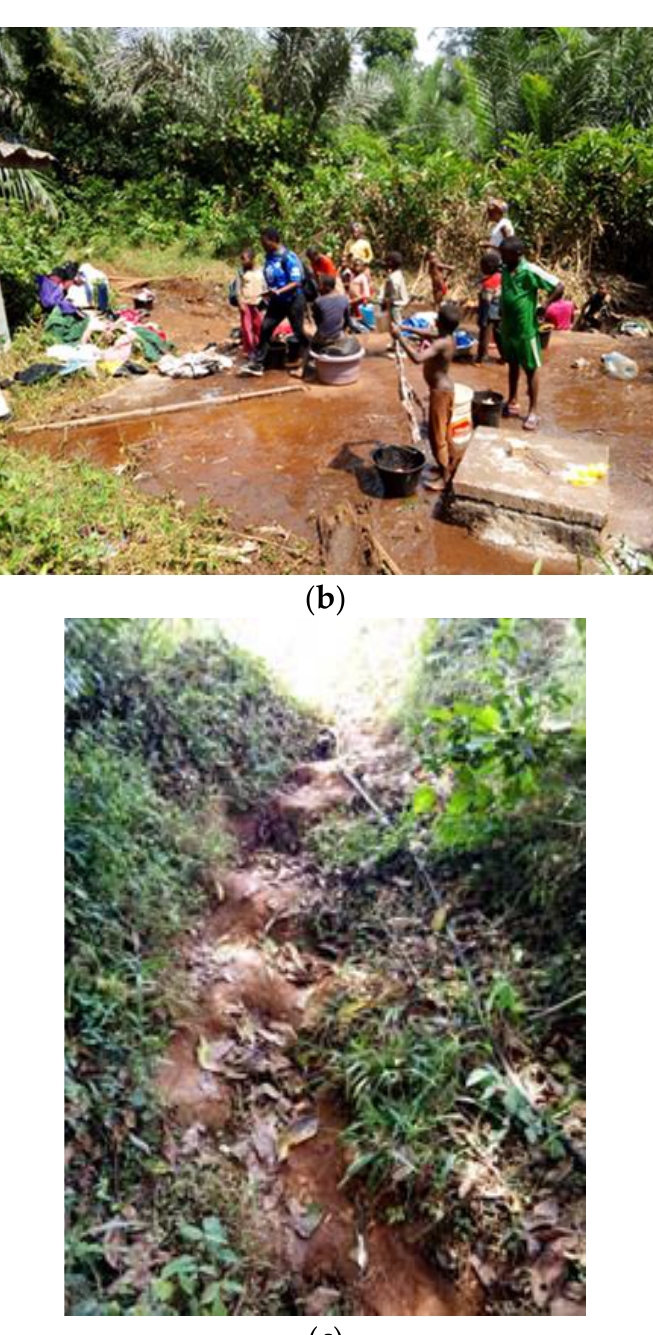
Figure 5. Photograph of protected springs in Feutap 1 ( a ), Feutap 2 ( b ), and a section of path to the spring of Feutap 2 ( c ). The spring of Feutap 2 is locally termed ‘Spring NOBRA’. Own photograph, 9 January 2022.